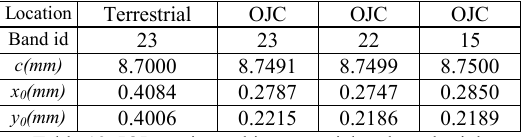
Table 12. IOPs estimated in terrestrial and on-the-job calibration (OJC) band